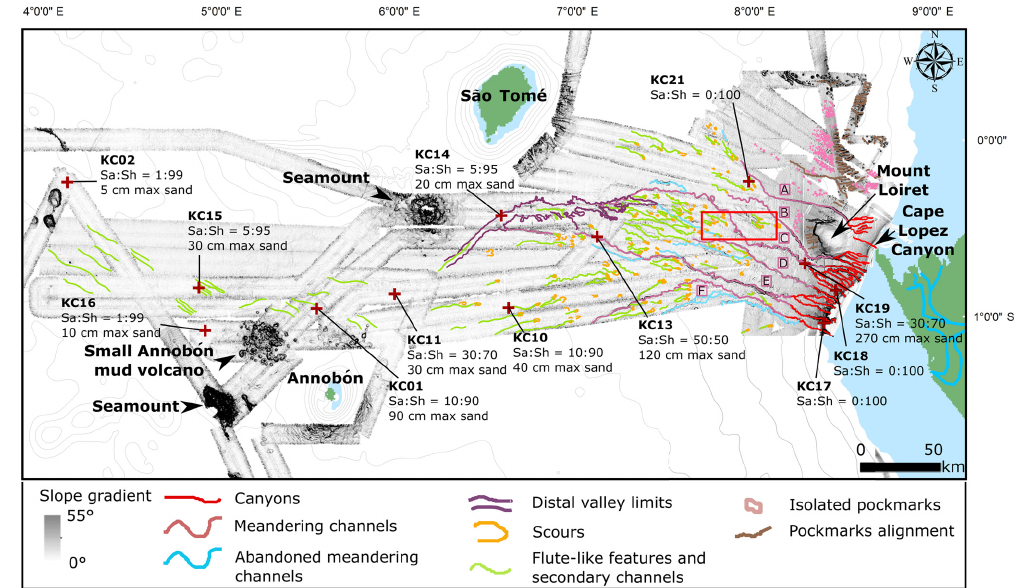
Figure 6. Interpreted gradient-shaded map of the Ogooue Fan showing the main features of the fan. A, B, C, D, E and F are the six main channels discussed in the text. The sand / shale ratio of the cores are shown (Sa : Sh) as well as the maximum sand-bed thickness in each core (max sand). A close-up view of the red rectangle is presented in Fig. 8.